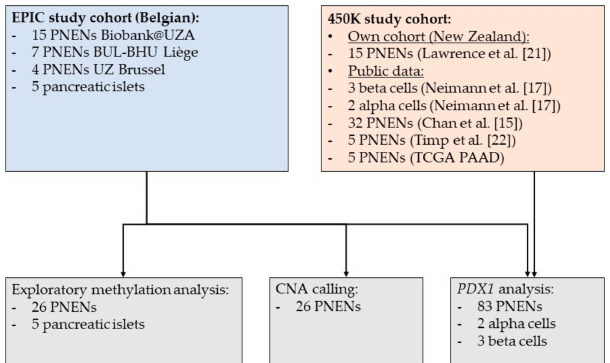
Figure 1. Overview of the study cohort and the analyses that were performed on (subsets of) the cohort. (CNA, copy number alteration; PNEN, pancreatic neuroendocrine